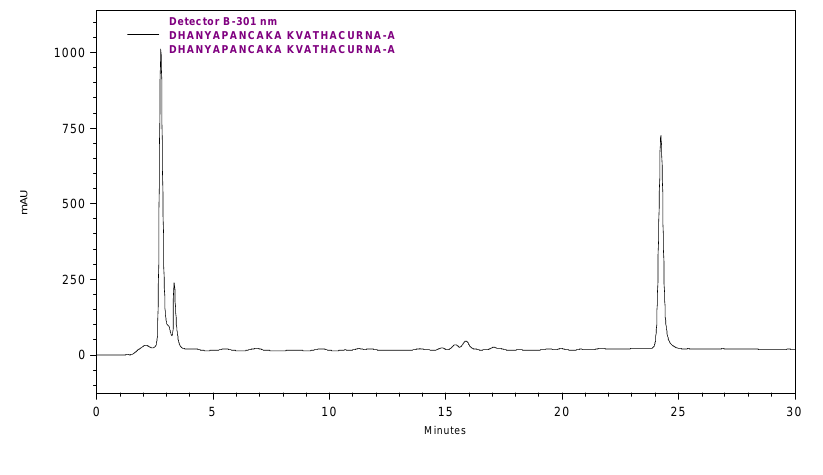
FFigure 1igure 1. HPLC Chromatogram of Dhanyapanchak Kwatha Curna